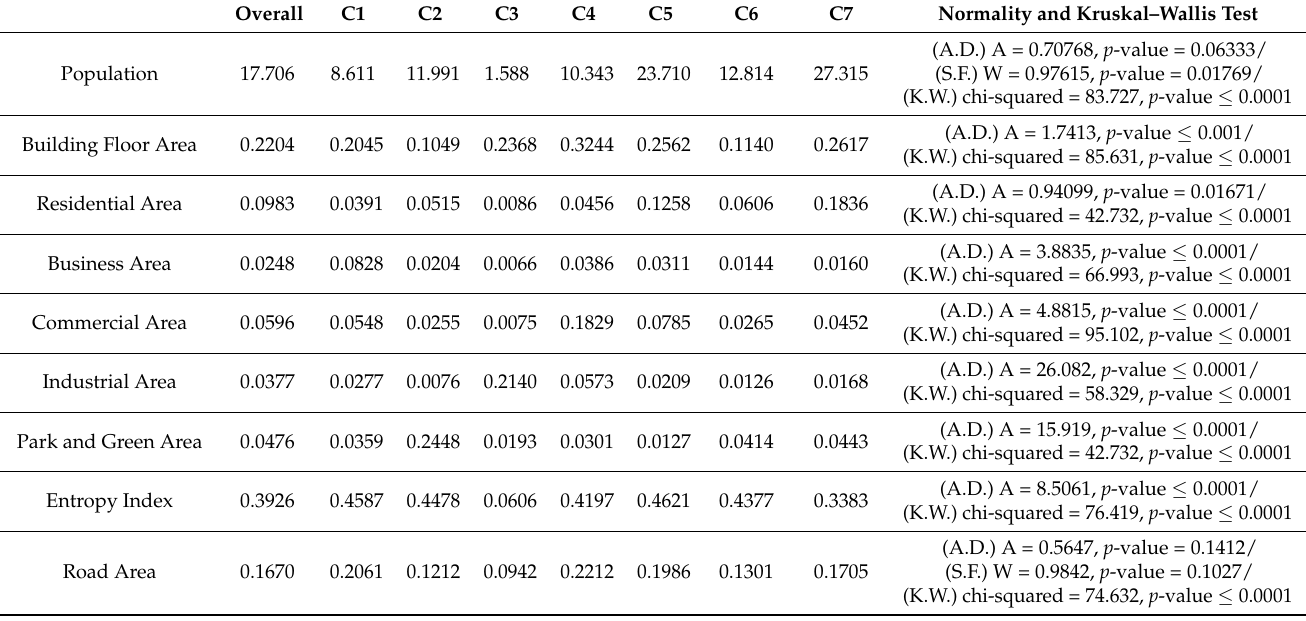
Table 3. Analysis of normality and differences in cluster